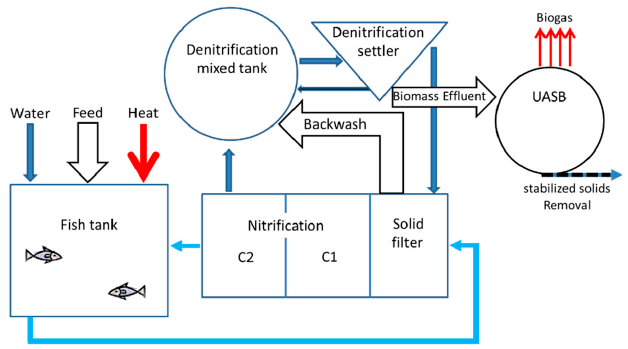
Figure 2. Scheme of three treatment loops recirculating aquatic system (RAS) including biofilter (nitrification), nitrogen removal unit (denitrification), and anaerobic digester for biogas production (After [27]).